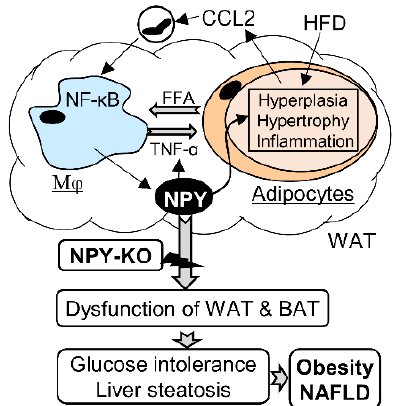
Figure 6. NPY antagonism ameliorates HFD-induced obesity and NAFLD pathogenesis. The ex- pression of macrophage ( Mφ) NPY is increased by HFD that promotes adiposity and TNFα -medi- ated inflammation through CCL2-meidated macrophage infiltration to WAT, leading to develop- ment of obesity and NAFLD. Mice with deletion of NPY are protected against HFD-induced dys- function of WAT and BAT through control of inflammation and fat metabolism thereby ameliorat- ing obesity and NAFLD. NAFLD.